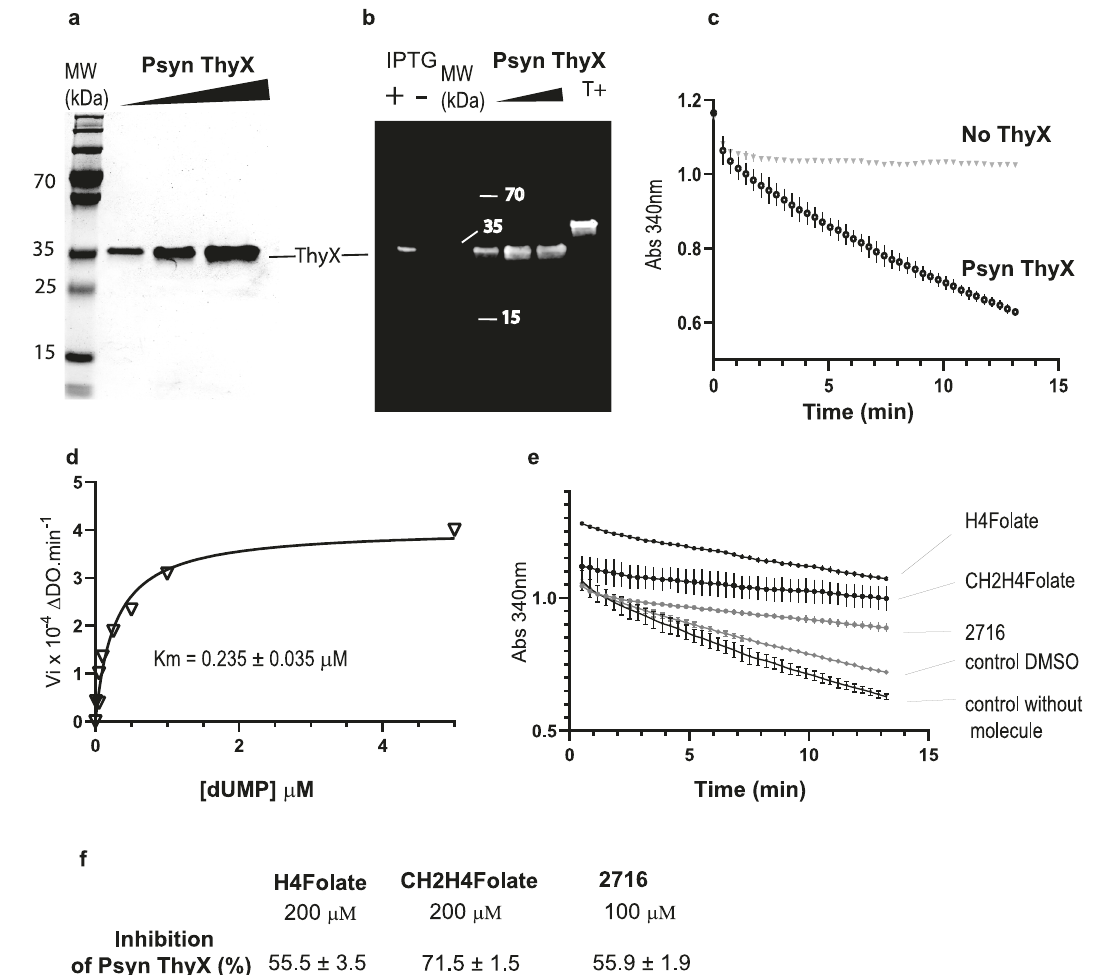
Fig. 7 | Biochemical characterization and inhibition analyses of Psyn ThyX. a 12%TGX ™ PAGEof Psyn ThyXpuri fi edbyone-stepaf fi nitychromatography.0.5,1, and 2 micrograms of puri fi ed protein were loaded from the left to the right. MW: molecularmarker. b WesternimmunoblotofIPTG-inducedandnon-inducedwhole celllysatesof E.coli FE013usinganti-Hismonoclonalantibodies.Asinglebandwith an apparent molecular mass of ~37 kDa is revealed. T + : control lane ( Pyrococcus abyssi RNA ligase). Panels a and b show representative plots from two different biological replicates. c Representative NADPH oxidation activity curves of Psyn ThyXasmeasuredfollowingtheabsorptionchangeat340nm.Thecontrolwithout